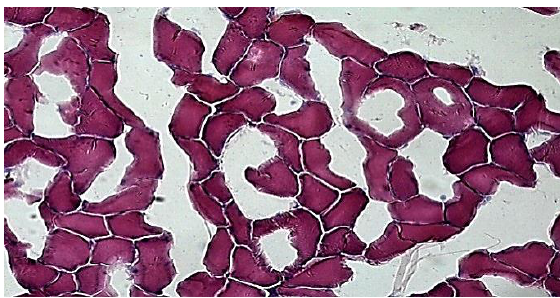
Fig. 3. Striated muscle tissue of the control samples of the refrigerated pork neck on the bone packed using MAP and irradiated at a dose of 8 kGy.